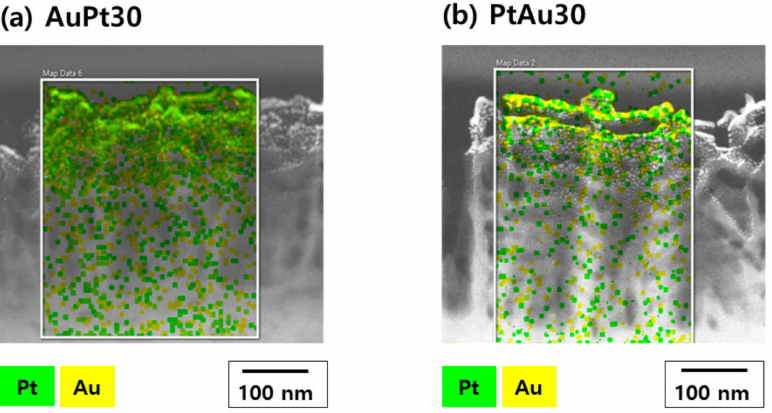
Figure 3. TEM characterization of ( a ) AuPt–TiO 2 nanotubes (AuPt30) and ( b ) PtAu–TiO 2 nanotubes